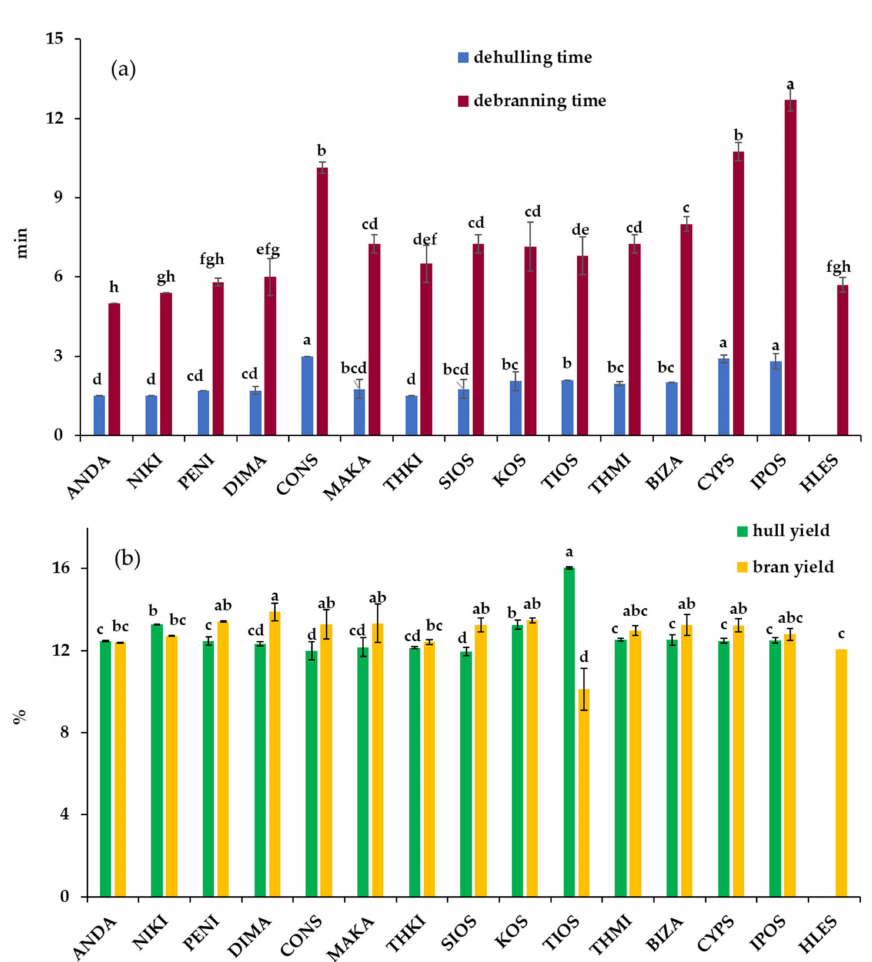
Figure 1. Comparison of dehulling and debranning time ( a ) and hull and bran yield ( b ) among barley varieties tested. Bars with no letter in common are significantly di ff erent from each other ( p ≤ 0.05). Correlation coe ffi cients indicated that pearling time of hulled barley grains was most a ff ected by weight, kernel width and thickness (Table 2). It could be concluded that the smaller, narrower and thinner grains require longer pearling times using the laboratory pearling device, whereas the length had no significant e ff ect. In this study, we have found that the whiteness and brightness of PG were insignificantly correlated ( p > 0.05) with pearling time, in contrast to the observations of Edney et al. [24], who indicated a significantly negative correlation between them. The whiteness of PG significantly increased with wider, larger and brighter grains, whereas the brightness was indicated highly positive correlation ( p ≤ 0.001) to grain weight, thickness and width. Positive highly significant correlations were also observed between barley grain dimensions and weight, as well as between grain thickness and width. Correlation analysis showed that grain weight and size are important parameters that should be considered in the barley pearling